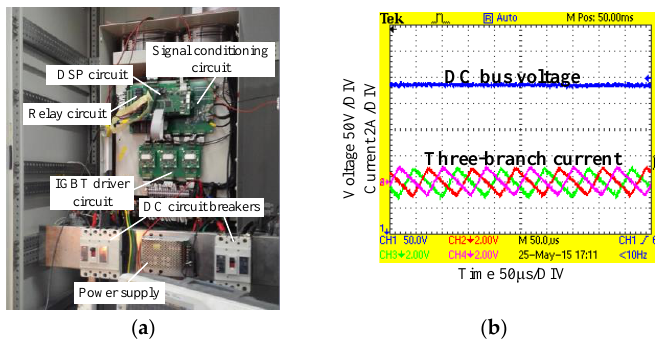
Figure 2. Prototype and experiment waveforms of the TIDC: ( a ) the 50 kW prototype of the TIDC; and ( b ) the three-branch currents of the TIDC.